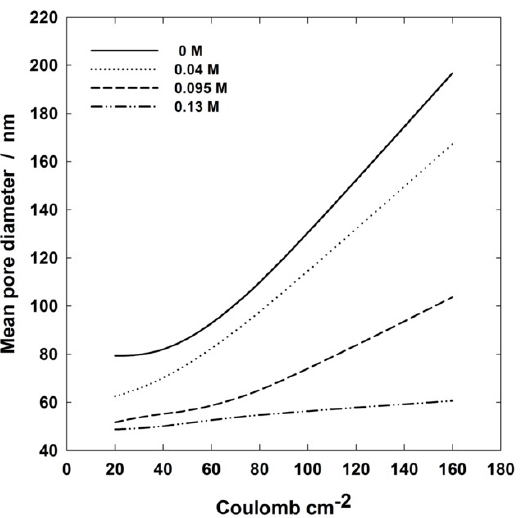
Figure 11. Pore mean diameter vs. charge density plots of PAA layers formed at 160 V and 0 °C in 0.4 M H 3 PO 4 aqueous solutions containing different amounts of Al(OH) 3 .